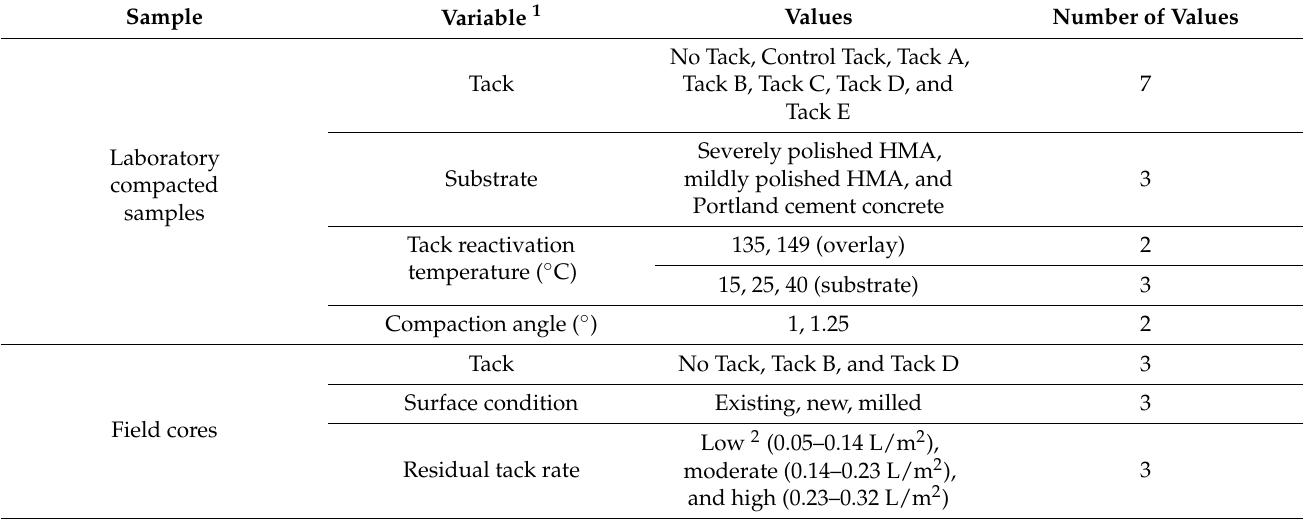
Figure 1. TxDOT specifications for Type C and D mixtures. Table 2. Test factorial for interlayer shear